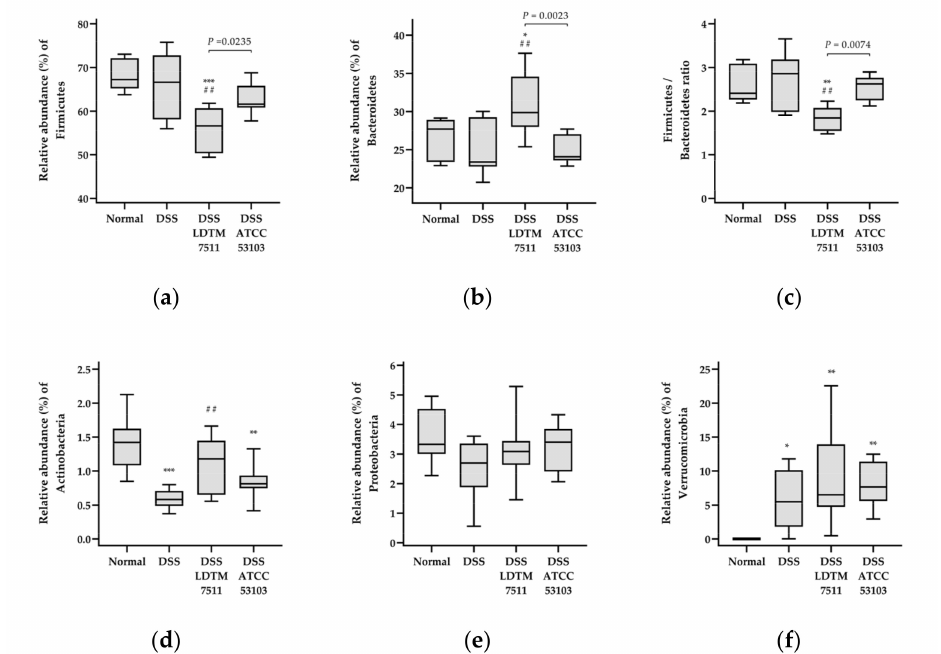
Figure 5. Relative abundance (%) of the dominant phylum and Firmicutes / Bacteroidetes ratio. ( a ) Firmicutes; ( b ) Bacteroidetes; ( c ) Firmicutes / Bacteroidetes (F / B) ratio; ( d ) Actinobacteria; ( e ) Proteobacteria; ( f ) Verrucomicrobia. Statistical significance is indicated as follows: * p < 0.05, ** p < 0.01, and *** p < 0.001, compared to the normal group; ## p < 0.01, compared to the DSS group; n = 8 in each group.